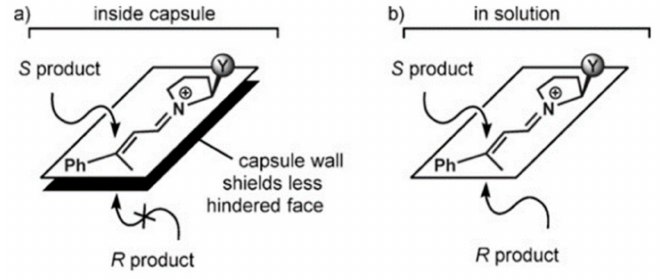
Figure 3. Hypothesis for the di ff erent selectivity inside capsule 2 (reproduced from Ref. [28], with permission of John Wiley and Sons).